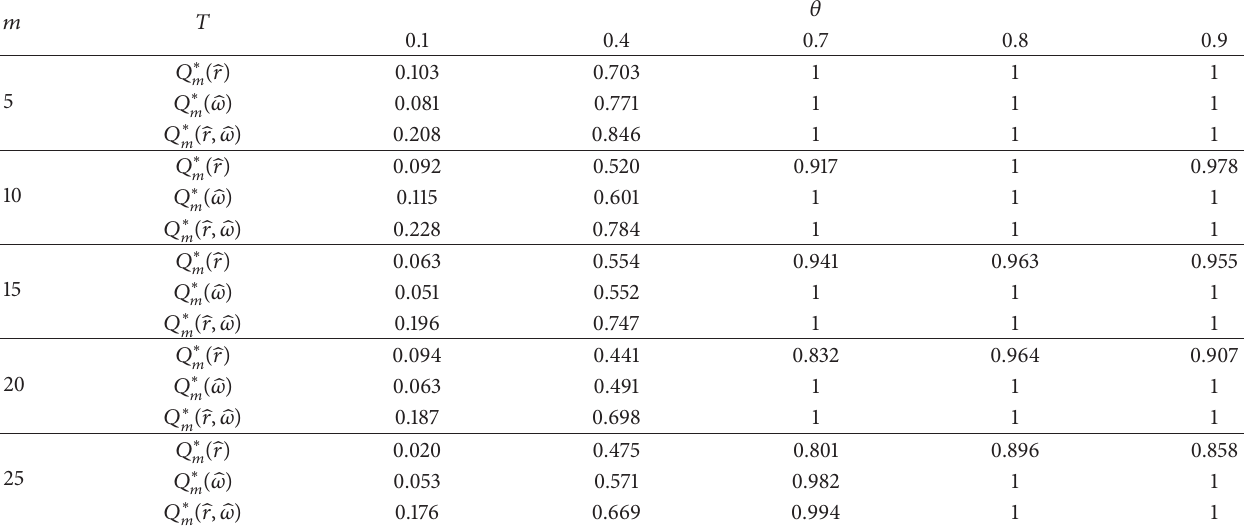
Table 5: Empirical power by fitting an AR (1) process against an ARMA (1, 1) process: 𝑦 𝑡 = 0.8𝑦 𝑡−1 + 𝜀 𝑡 + 𝜃𝜀 𝑡−1 using 1000 Monte Carlo